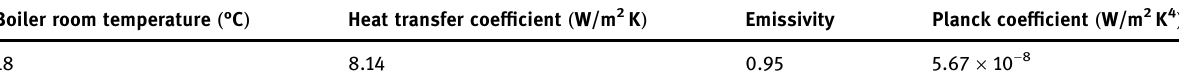
Table 2: Values and coe ffi cients used in calculations